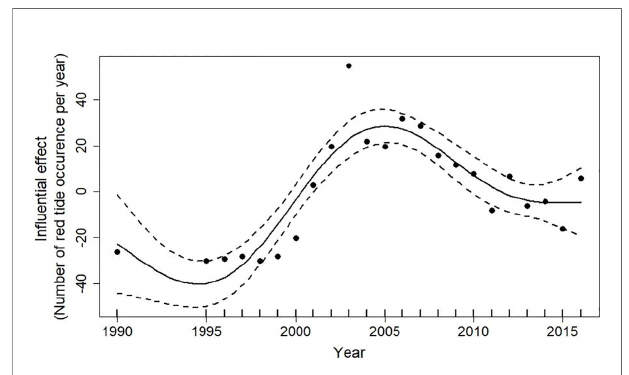
FIGURE 7 | Analysis of number of occurrences of red tides in the East China Sea in 1990-2017 based on generalized